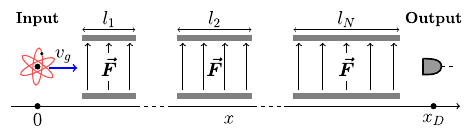
Fig. 2 Atom-polariton correspondence. Schematic picture of a physical system whose dynamical evolution is equivalent to that of the propagating two-polariton state de fi ned in Eq. (5): A two-level atom is injected from the left with speed v g (in analogy with the polariton group velocity) and propagates towards the detection region ( x = x D ), through